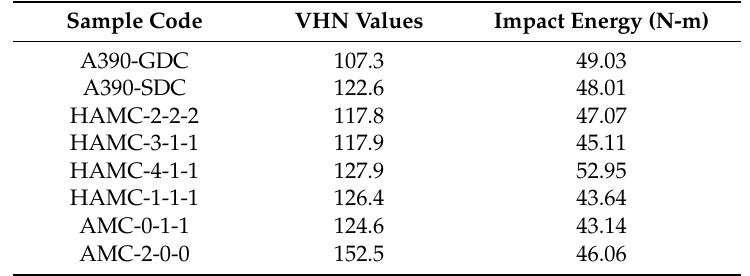
Table 4. Average values of Vickers Hardness Number (VHN) and impact energy.